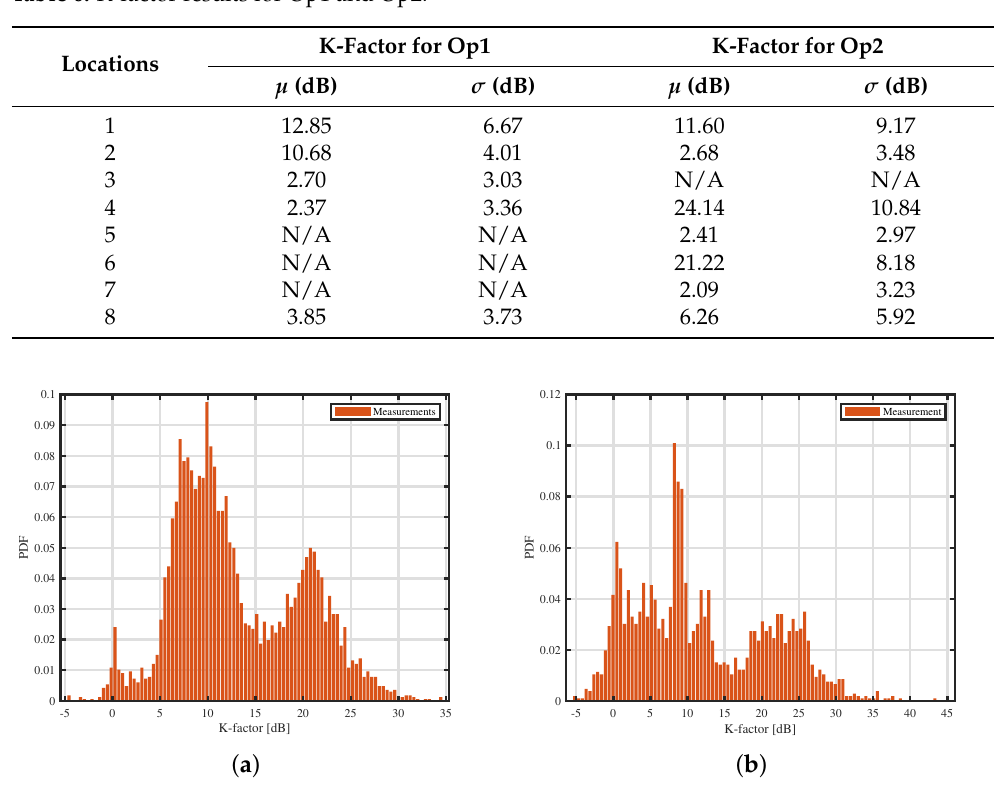
Figure 15. PDF of K-factor for Op1 and Op2 at the measurement location 1 ( a ) Op1; ( b )